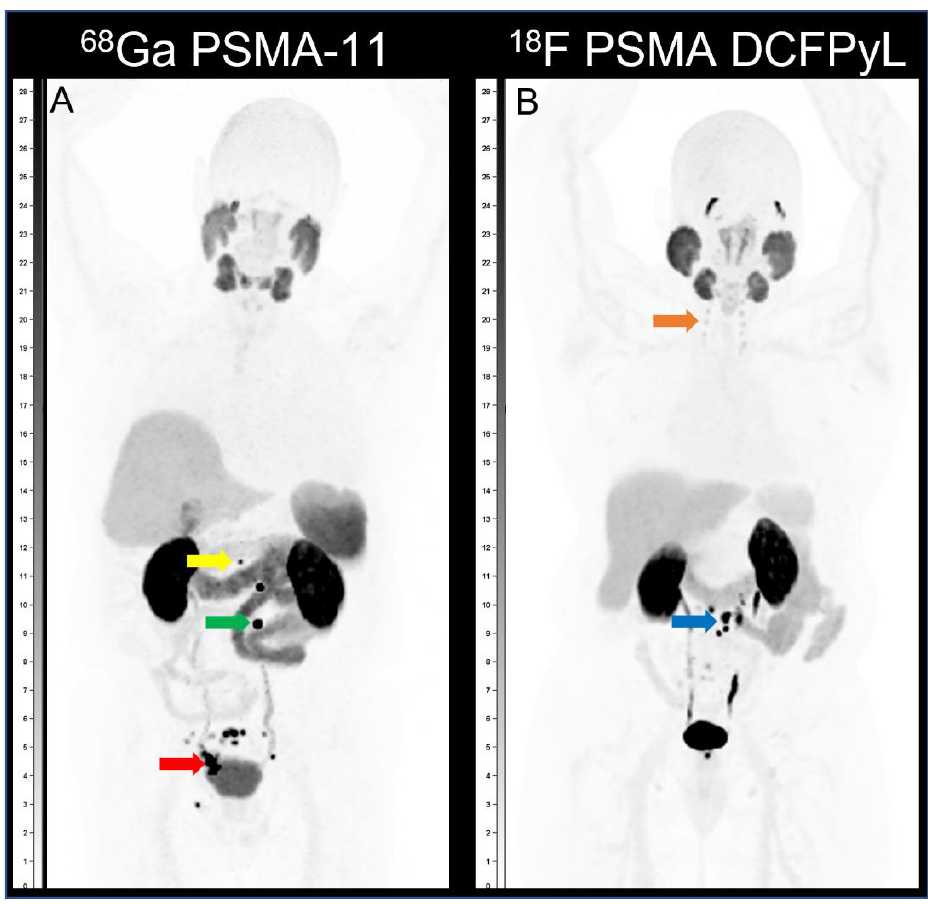
Figure 2. 68 Ga PSMA-11 and 18 F PSMA DCFPyL PET evaluation of mCRPC prior to 177 Lu PMSA-617 RLT. Two patients with mCRPC undergoing PSMA PET prior to 177 Lu PMSA-617 therapy. Patient A with Gleason score 3 + 4 = 7 prostate cancer status post prostatectomy, salvage radiation- and cryotherapy. PSA of 0.42 ng/mL at time of 68 Ga PSMA-11 PET/CT for evaluation prior to 177 Lu PSMA-617 therapy. Anterior view of 68 Ga PSMA-11 PET maximum intensity projection (MIP) ( A ) demonstrates intense PSMA uptake along the prostatectomy bed and rectum (red arrow) retroperitoneal and pelvic lymph nodes (green arrow) and osseous metastatic deposit involving the L1 vertebral body (yellow arrow). Patient B with Gleason 4 + 5 = 9 prostate cancer status post radiation therapy and androgen deprivation therapy, and PSA of 3 ng/mL. Anterior view MIP ( B ) demonstrates intense PSMA uptake along retroperitoneal lymph nodes (blue arrow). Incidental note of symmetric PSMA uptake along benign celiac ganglia (orange arrow).